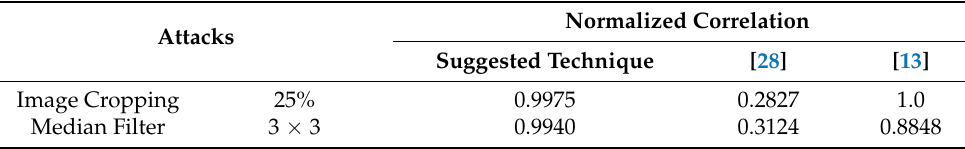
Table 8. Normalized correlation against image geometrical